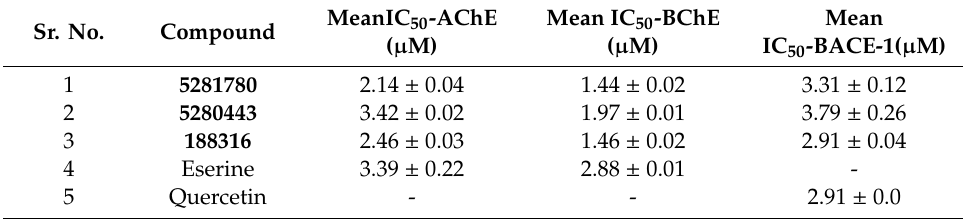
Table 4. Mean IC 50 and standard deviation of values of isolated compounds 5281780 , 5280443 , and 188316 , and control compounds eserine for AChE and BChE, and quercetin for BACE-1. Sr. No.